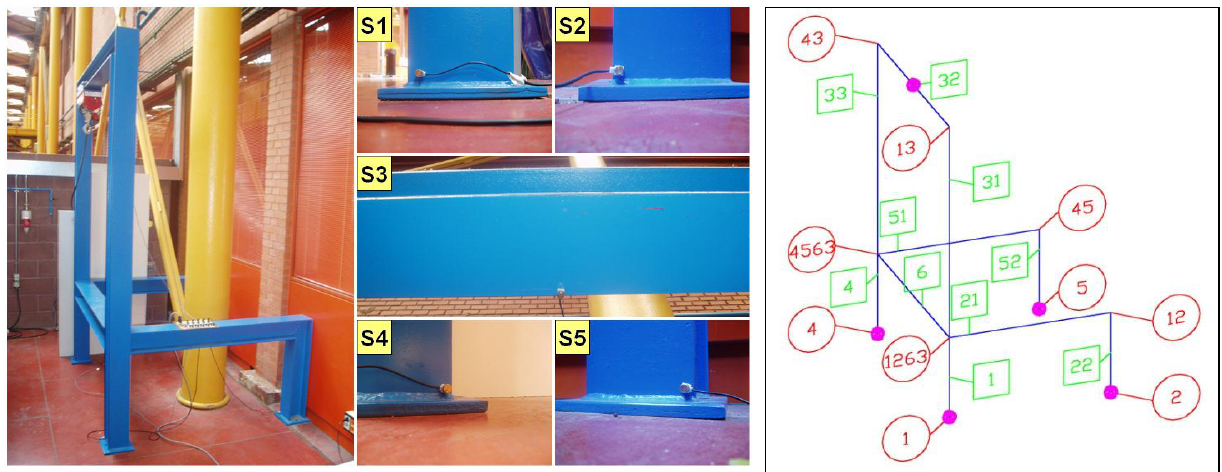
Figure 7. Geometrical description of the structure and